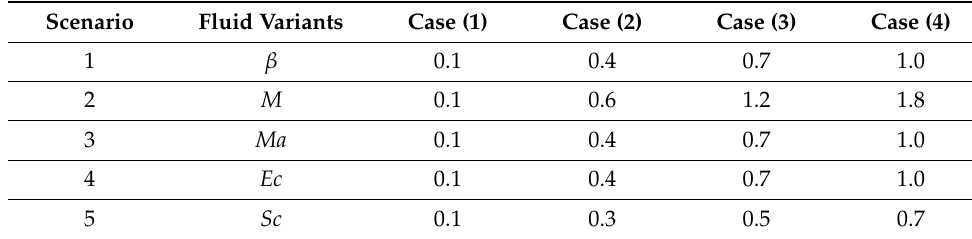
Table 2. Outcomes of LMT-ABPNN for variants of f (cid:48) ( η ) of